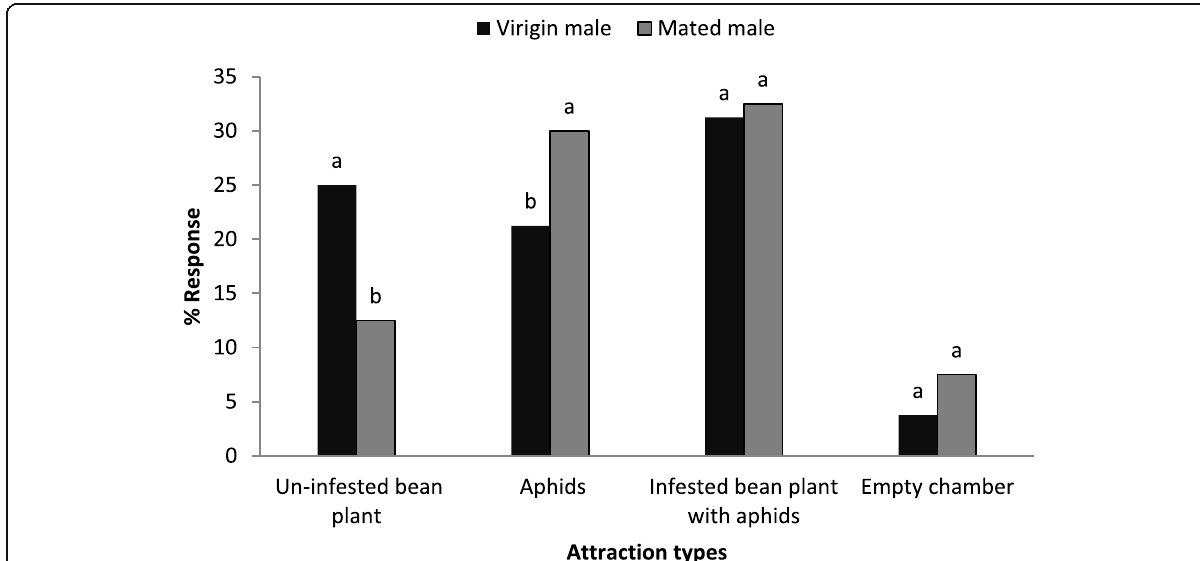
Fig. 1 Percentage of response of the virgin and mated males of Coccinella undecimpunctata to different odor sources, tested in a 4-arm olfactometer (single individual